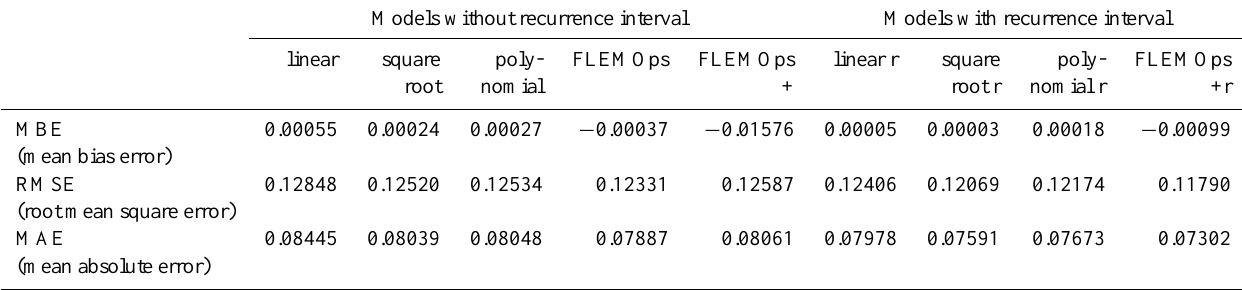
Table 6. Error statistics for relative loss estimates of cases estimated by all models.